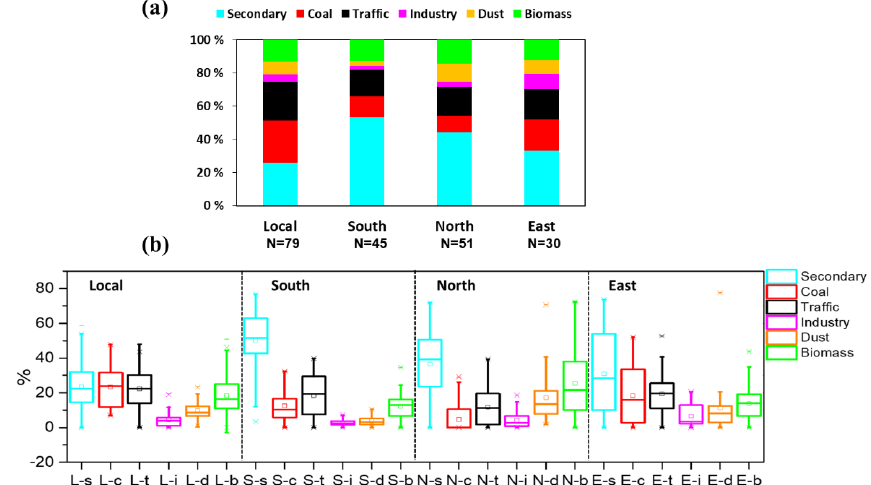
Figure 9. (a) The average source contribution (in percentage) for each type of footprint, and (b) a box chart of source contribution for four types of footprint during the whole sampling period. N in (a) represents the number of cases. The capital letters in (b) stand for the type of footprint (L for local, S for south, N for north, E for east) and the lowercase letters stand for different sources (s for secondary source, c for coal combustion, t for traffic source, i for industrial source, d for dust and b for biomass